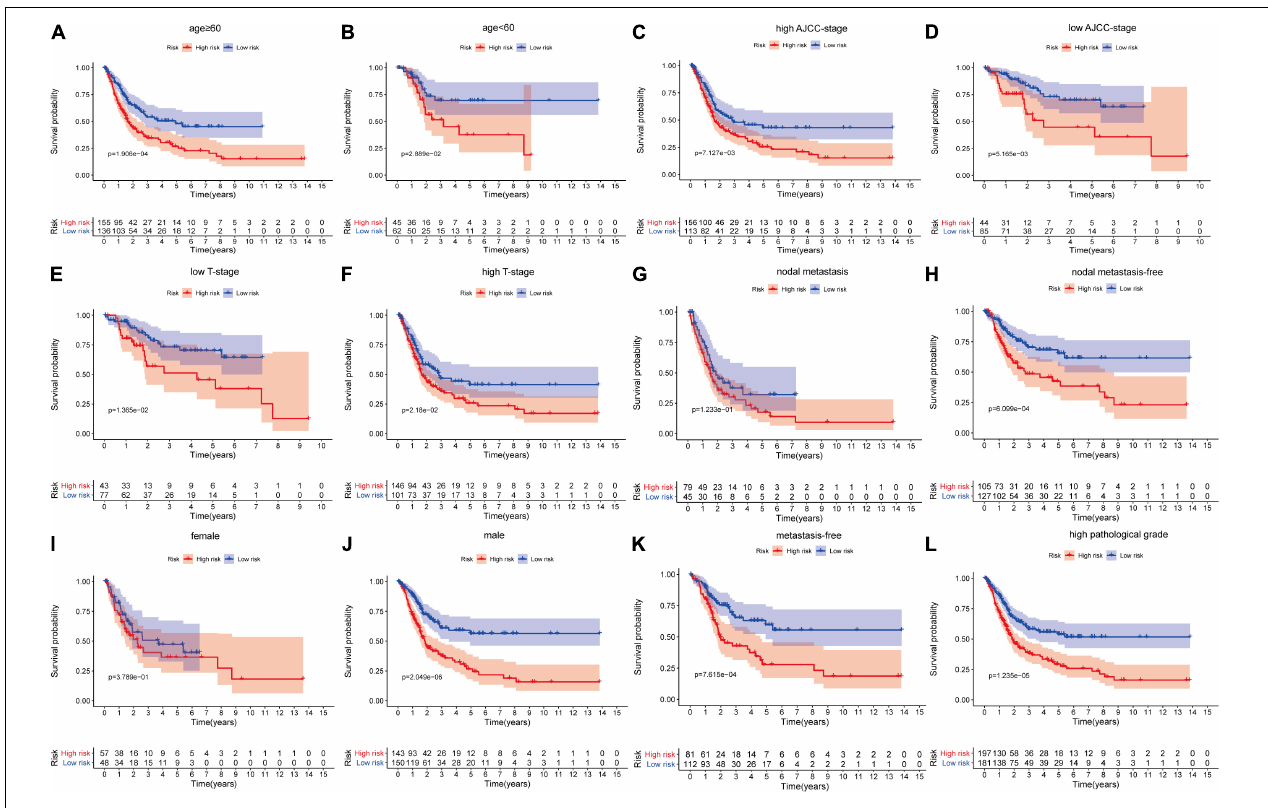
FIGURE 5 | The survival outcomes of bladder cancer patients with different risk scores in subgroups of (A) age ≥ 60, (B) age < 60, (C) high AJCC-stage, (D) low AJCC-stage, (E) low T stage, (F) high T stage, (G) nodal metastasis, (H) nodal metastasis-free, (I) female, (J) male, (K) metastasis-free, and (L) high pathological grade, in the training dataset. The patients with higher risk scores had a worse overall survival compared with those with lower risk scores in the subgroups of (A) age ≥ 60, (B) age < 60, (C) high AJCC stage, (D) low AJCC stage, (E) low T stage, (F) high T stage, (H) nodal metastasis-free, (J) male, (K) metastasis-free, and (L) high pathological